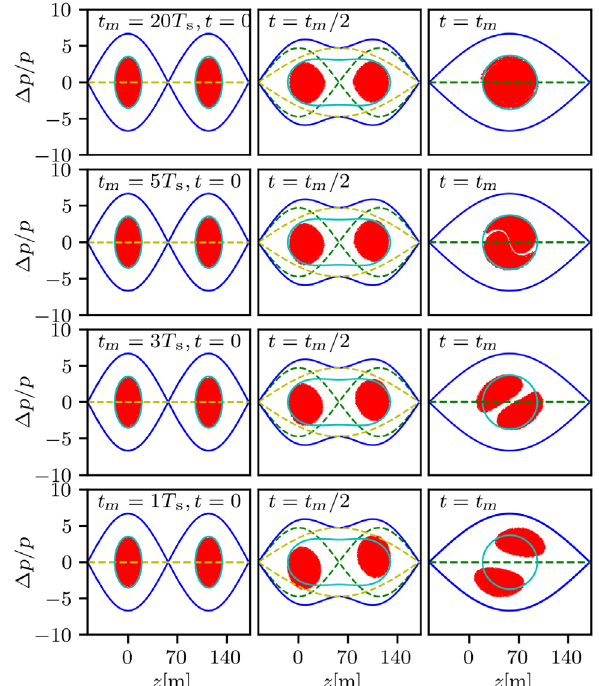
FIG. 9. Snapshots of phase-space distribution during bunch merging in the absence of intensity effects with four different ¼ 20 T merging times t , 5 T , 3 T , and 1 T . The three panels m s 0 s 0 s 0 s 0 in each row from left to right represent three time instants: at the = 2 ), and at the end beginning ( t ¼ 0 ), in the middle ( t ¼ t m ( t ¼ t ) of the merging process. The blue lines denote the m separatrix orbit in the dual harmonic system. The green and the yellow lines represent the separatrix orbit in the harmonic ¼ 2 and h ¼ 1 , respectively, and the light blue (cyan) lines h i f denote the trajectories of the constant Hamiltonian at the bunch